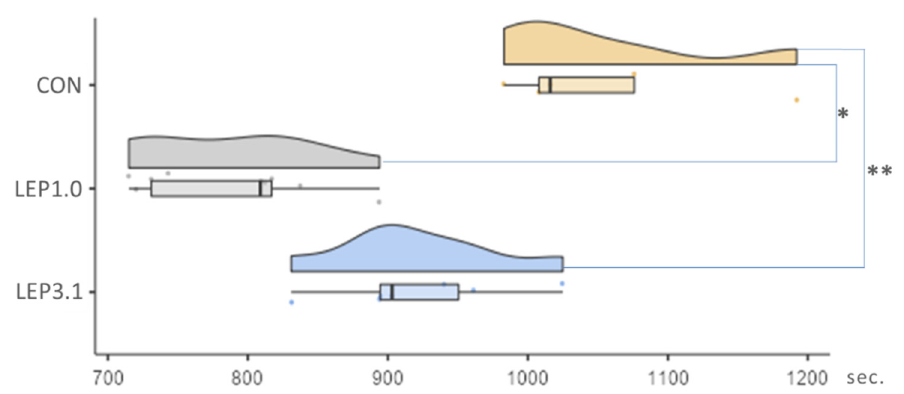
Figure 5. Total duration of reperfusion ventricular tachycardia. CON, control; LEP1.0, leptin 1.0 nM; LEP3.1, leptin 3.1 nM. Data are presented as mean ± standard deviation. * p < 0.0001; ** p < 0.014. The mean HR during reperfusion-induced ventricular tachycardia was significantly lower in the LEP1.0 group than in the CON group (Figure 6).